Question: Sum up the contents of this chart in one sentence.
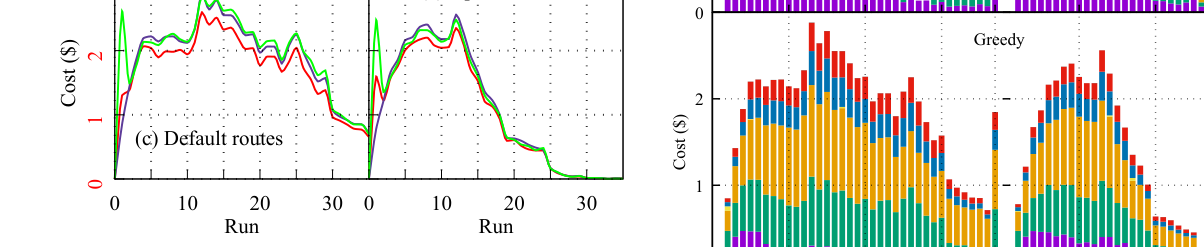
Answer: The influence of traffic patterns on optimization ob- jectives reveals distinct differences in workload distribution among placement approaches, while service provisioning costs are at a similar level.